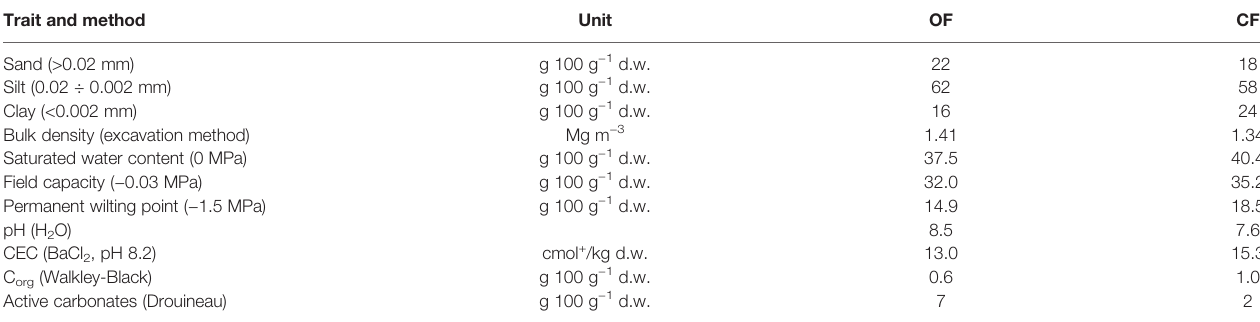
TABLE 1 | Main physical and chemical traits of the soils under organic farming (OF) and conventional farming (CF). Trait and method Unit OF CF Sand (>0.02